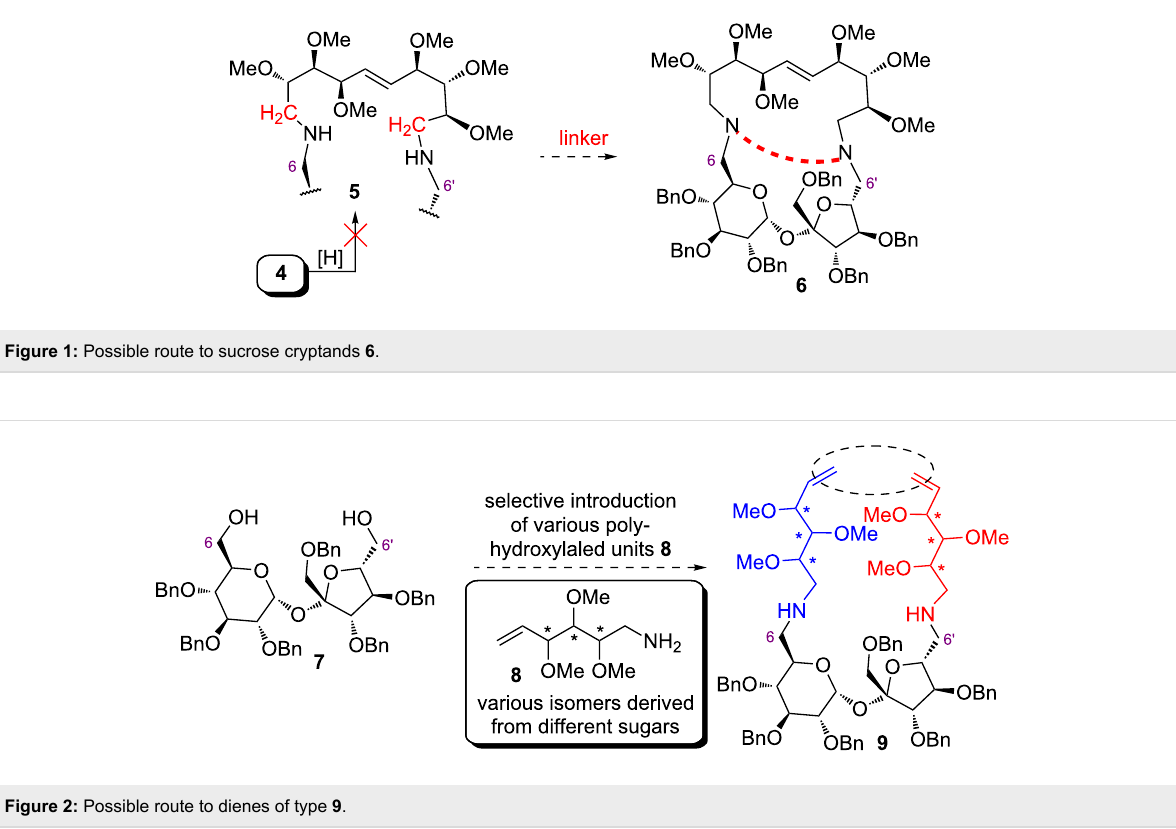
The reduction of the amide functions should lead to amines, which might be used as starting materials for the preparation of, e.g., cryptands 6 (Figure 1). All attempts, however, to reduce 4 to diamine 5 were